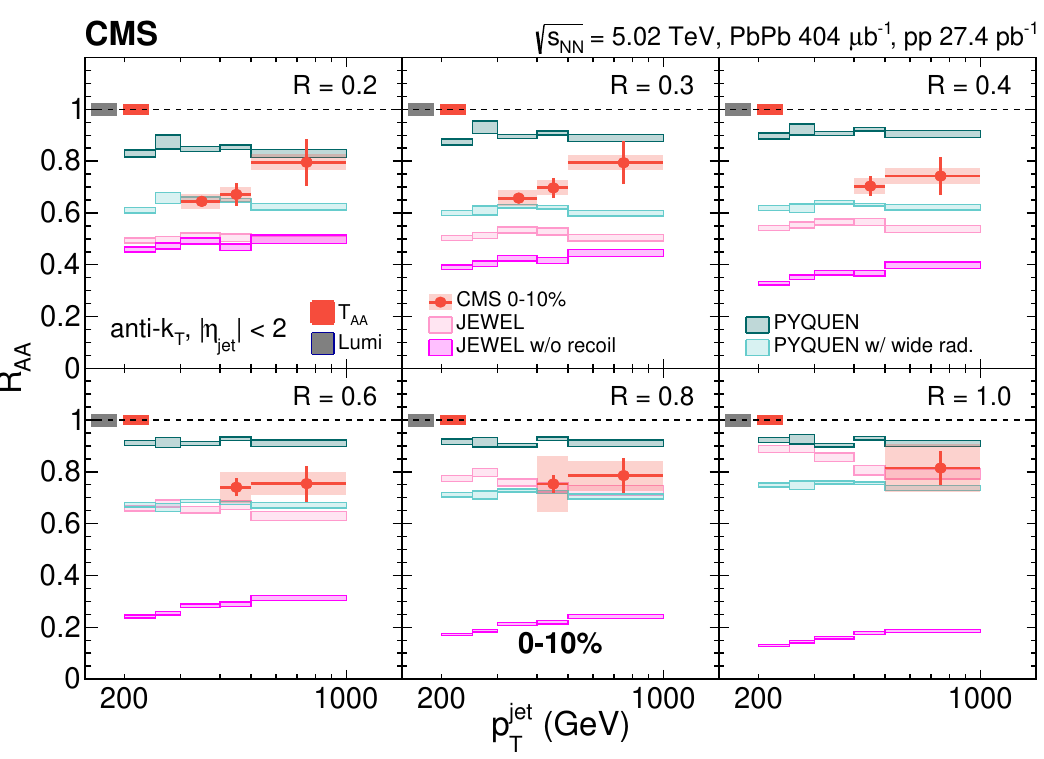
for jets with | η jet | < 2 . 0 , as a function of p jet , for various R and 0–10% cen- Figure 9 . The R AA T trality class. The statistical uncertainties are represented by the vertical lines, while the systematic uncertainties are shown as the shaded boxes. The markers are placed at the bin centers. Global uncertainties (integrated luminosity for pp and h T i for PbPb collisions) are shown as the colored AA boxes on the dashed line at R = 1 and are not included in the shaded bands around the points. AA The predictions from Jewel (fuchsia and pink) and pyquen (teal and turquoise) generators, shown as colored boxes, are compared to the